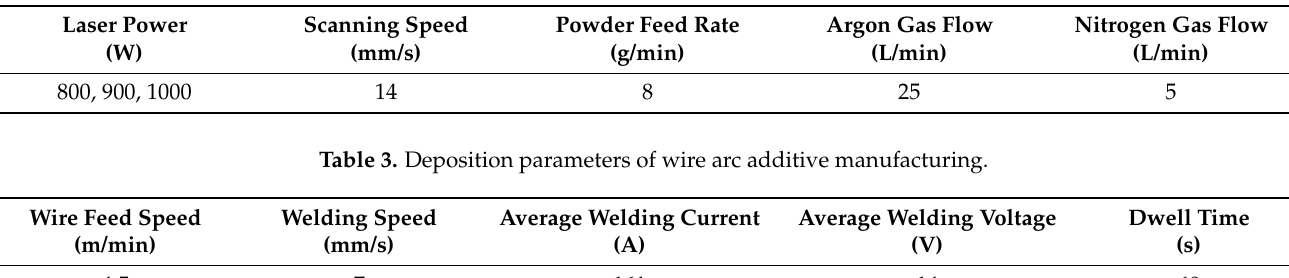
Figure 3. WAAM experimental setup: ( a ) Robot; ( b ) CMT welding machine; and ( c ) wire feed unit; ( d ) controller. Table 2. Deposition parameters of laser metal deposition.